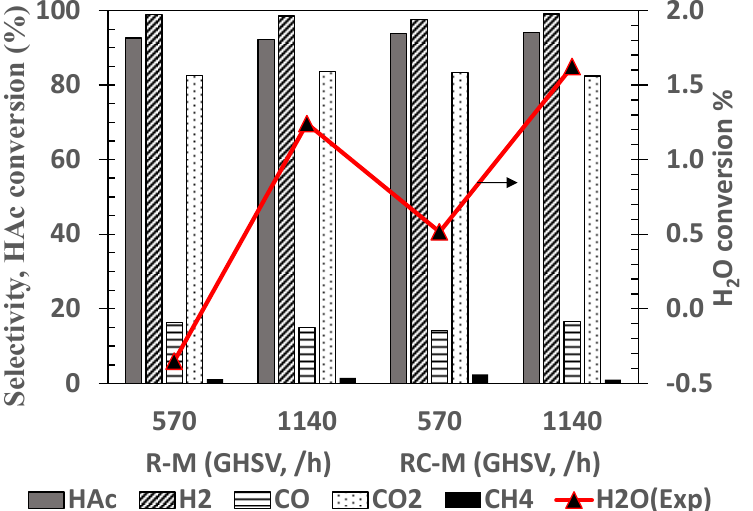
Figure 9. Influence of GHSV on feed conversion and dry product gas selectivity. S/C = 2, λ = 0.353 and hot product gas at 570 °C.